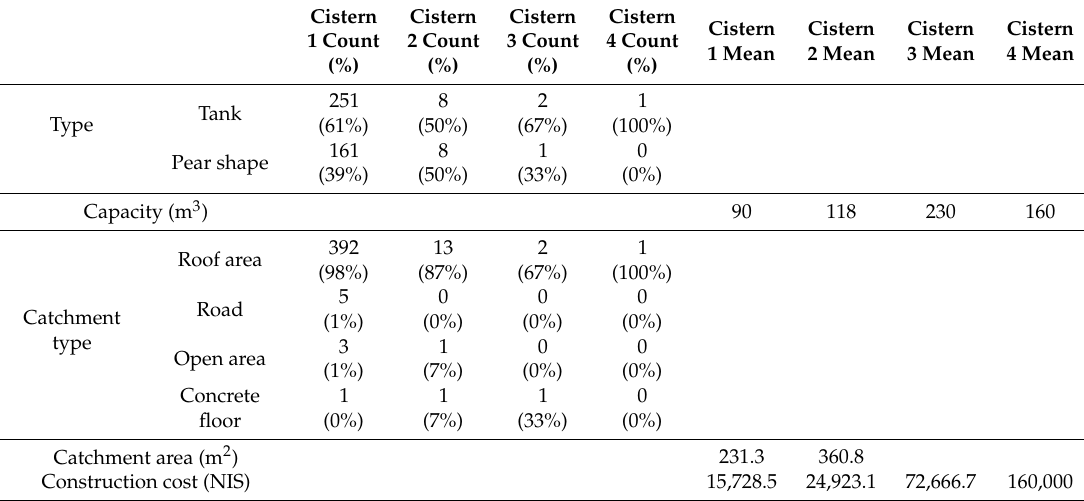
Table 1. Description of surveyed